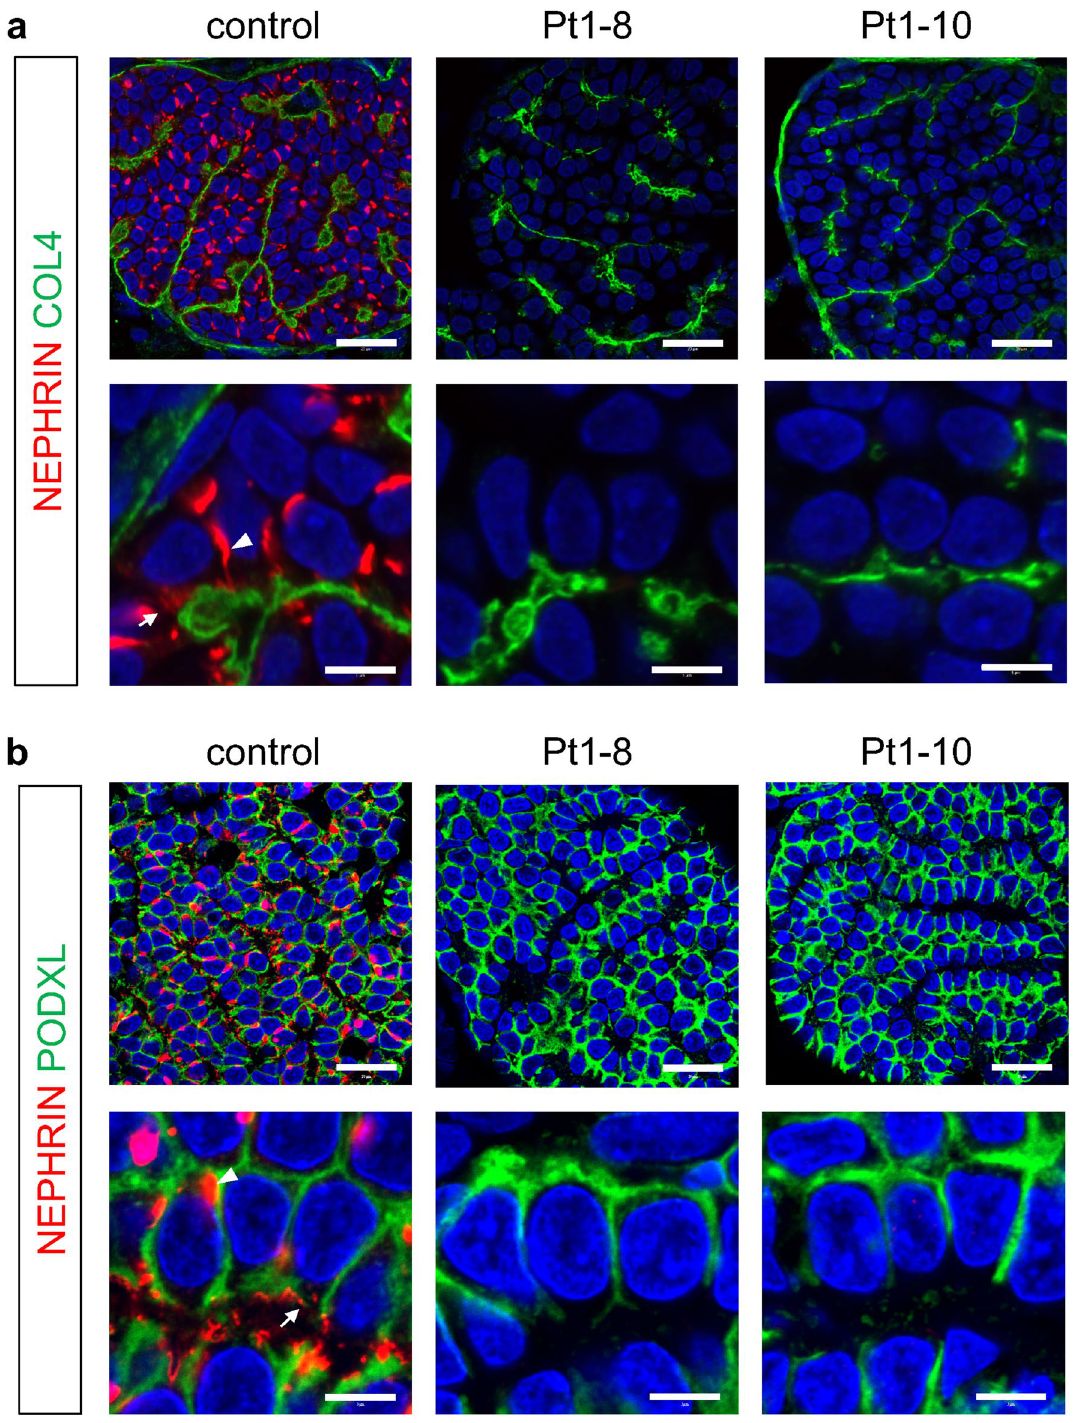
Figure 4. NEPHRIN expression is absent in Patient 1-derived podocytes. Section immunostaining of kidney organoids, showing the absence of NEPHRIN in Patient 1-derived podocytes (clones: Pt1-8, Pt1-10). Co-staining of NEPHRIN with type IV collagen (COL4) ( a ) or PODOCALYXIN (PODXL) ( b ) is shown. Scale bars: 20 µm for upper panels; 5 µm for lower